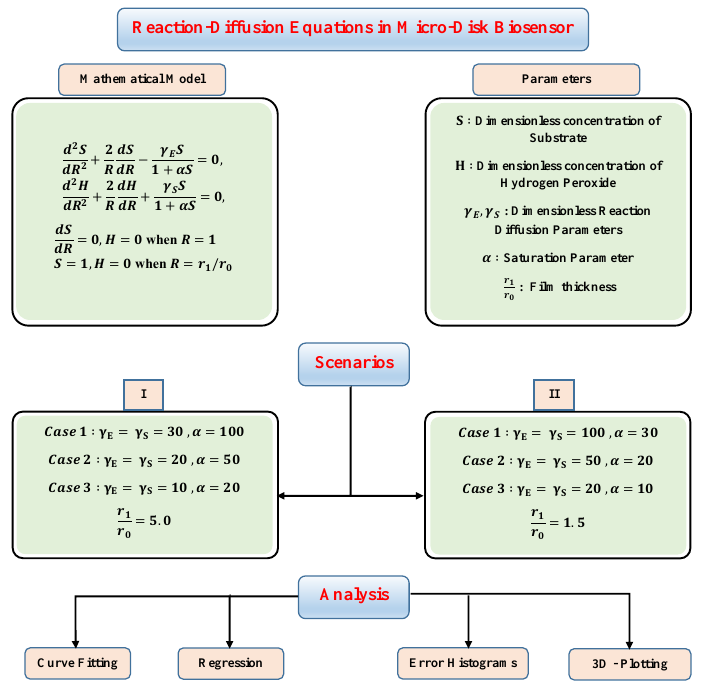
Figure 4. Different scenarios and cases of micro-disk biosensor.